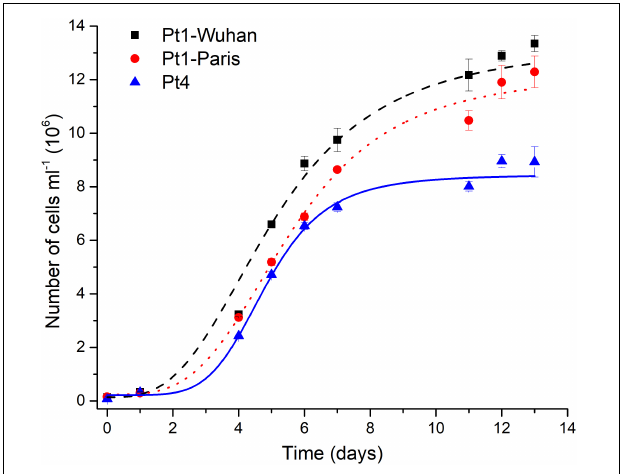
FIGURE 8 | Growth curves of the different ecotypes and strains of P. tricornutum in N-replete condition. A logistic model was used for the determination of growth rates.